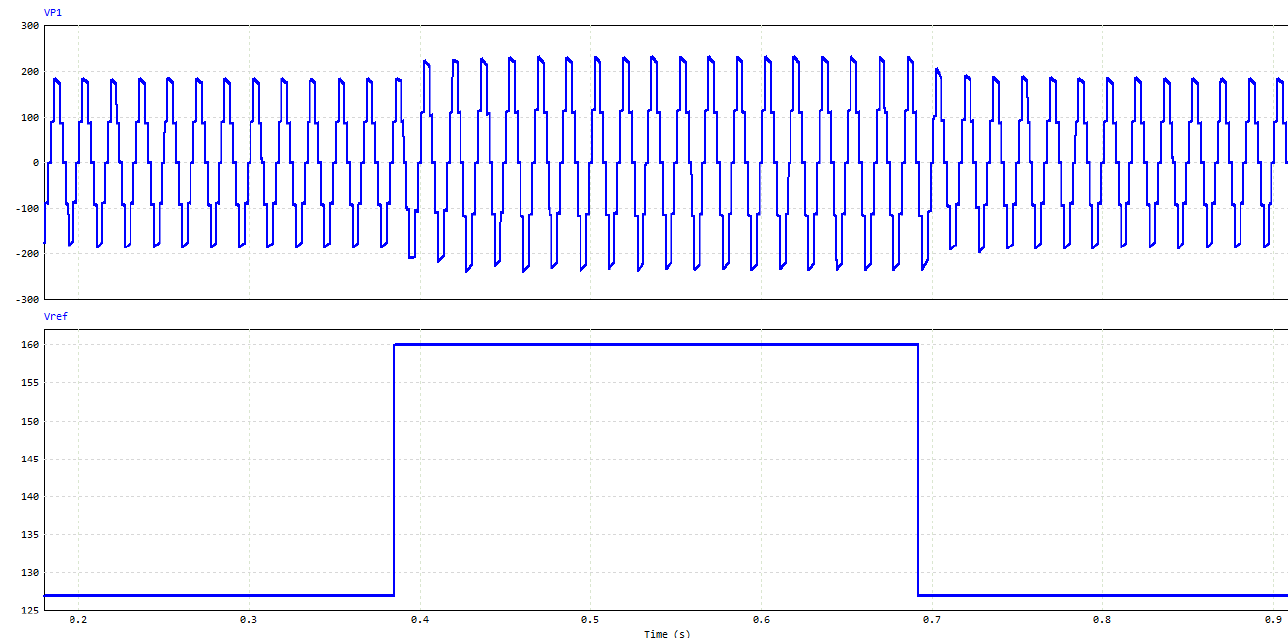
the input voltage source is changed from 12 to 15 V. input voltage source is changed from 12 to 15 V.